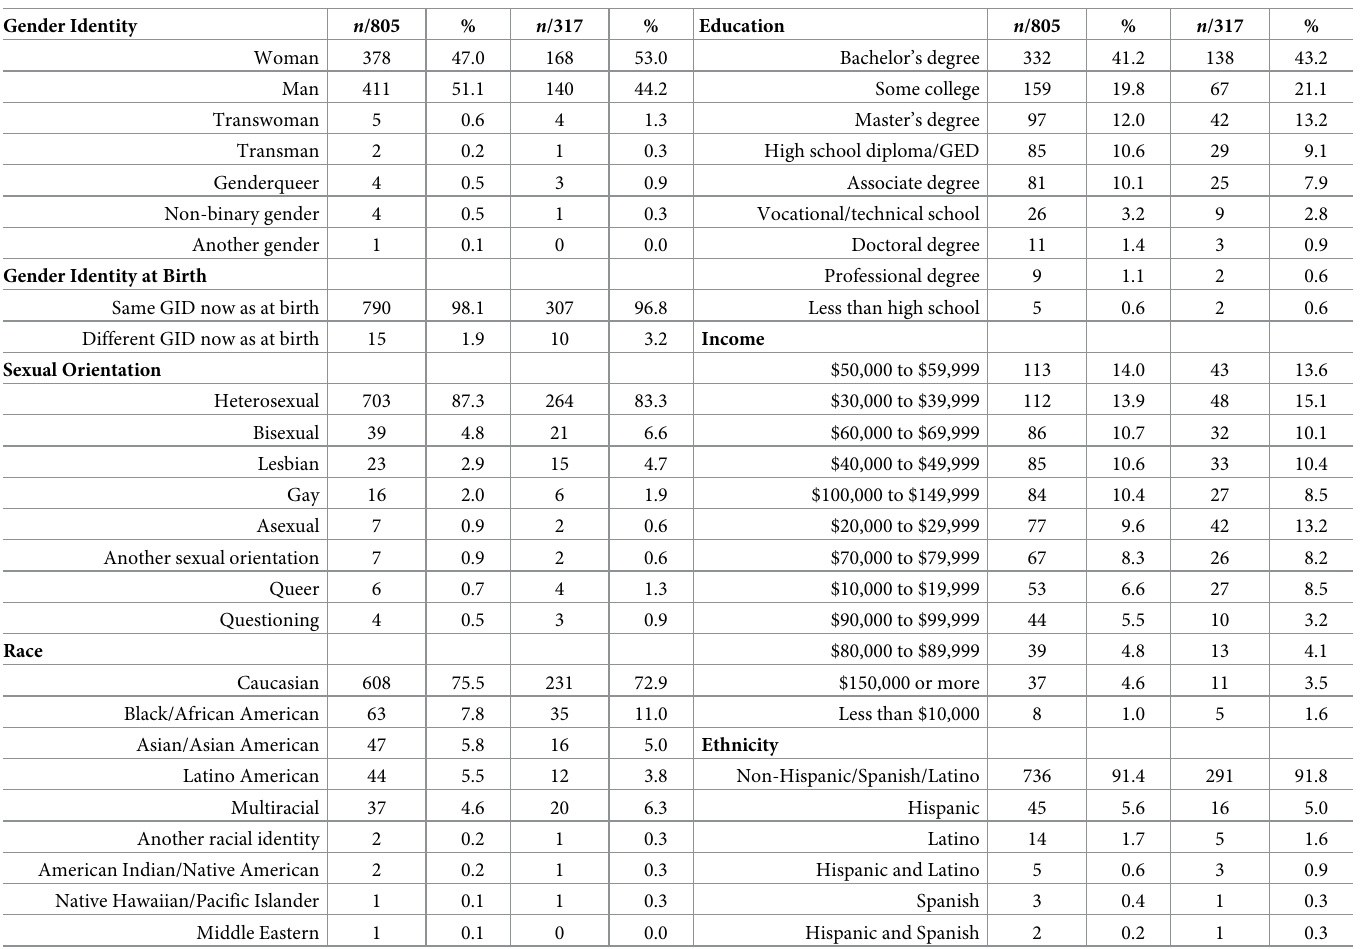
Table 1. Demographic information of full sample ( N = 805) and subset of sample ( n = 317) used in